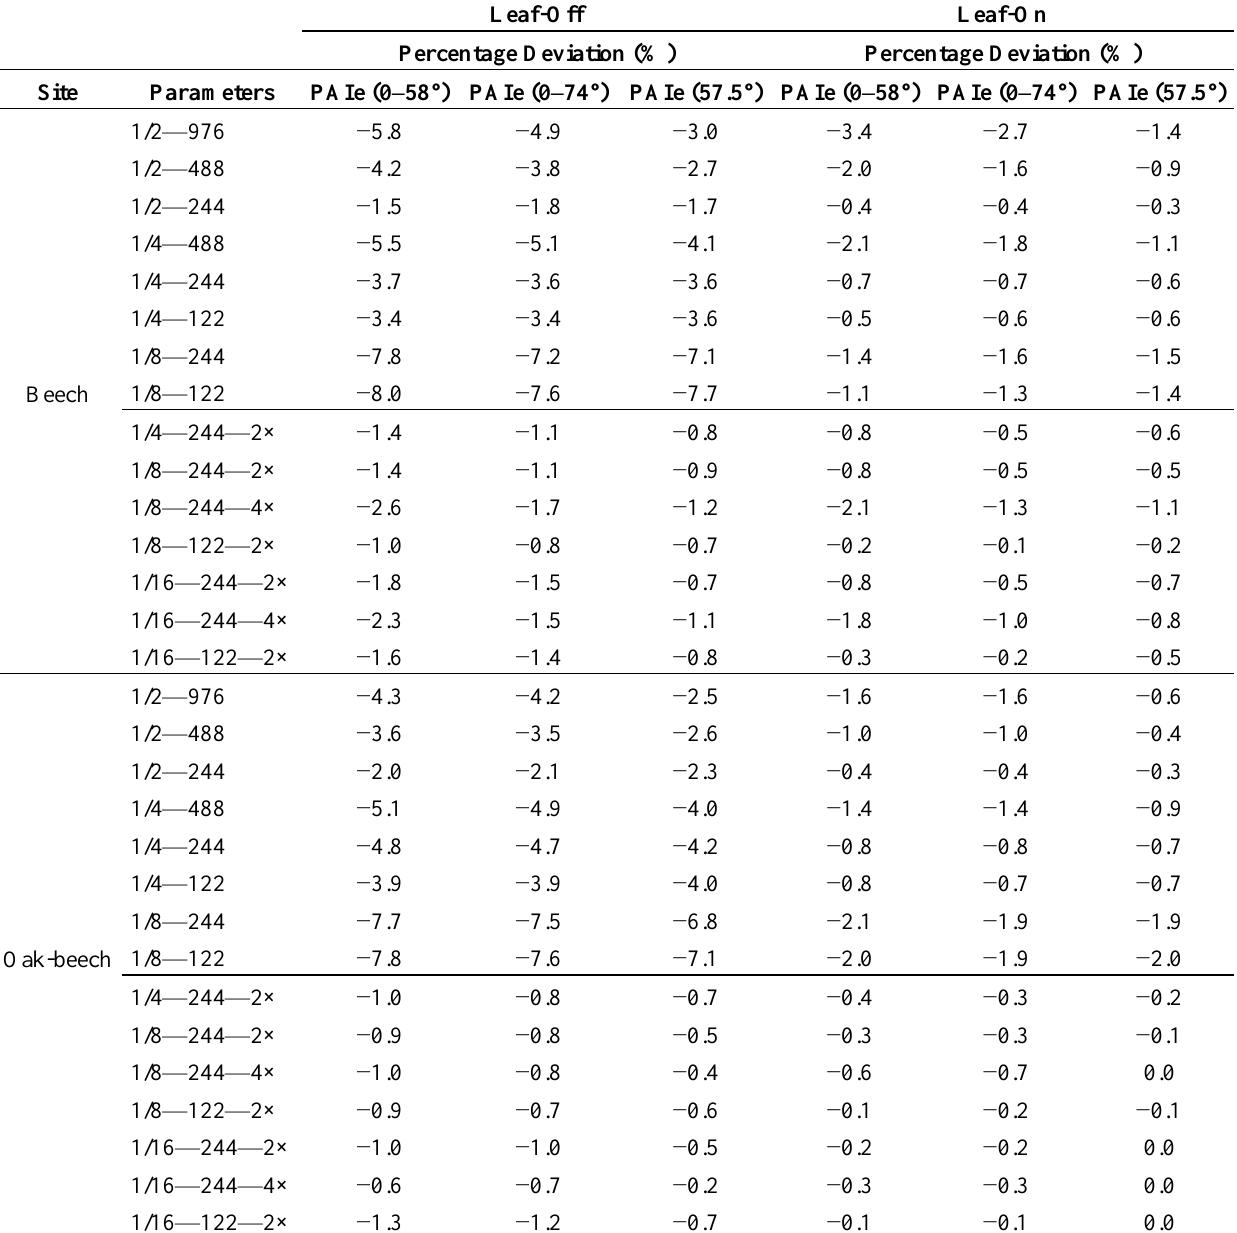
) caused by the majority filtering e derived from the unfiltered scans (―raw‖). e